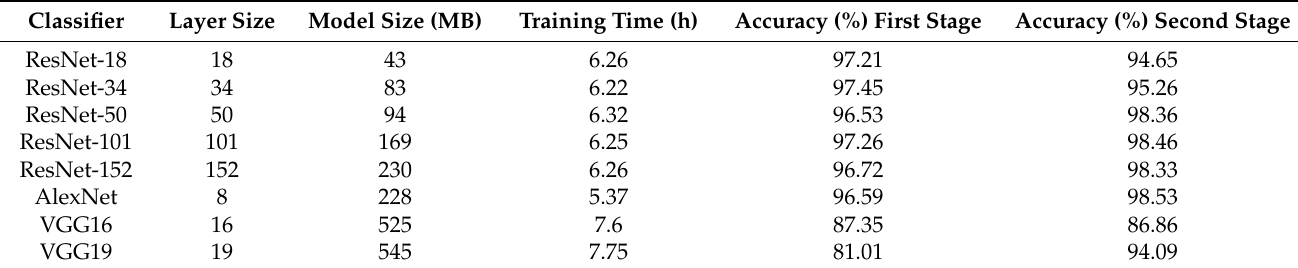
Table 15. Comparison of the proposed approach with previous